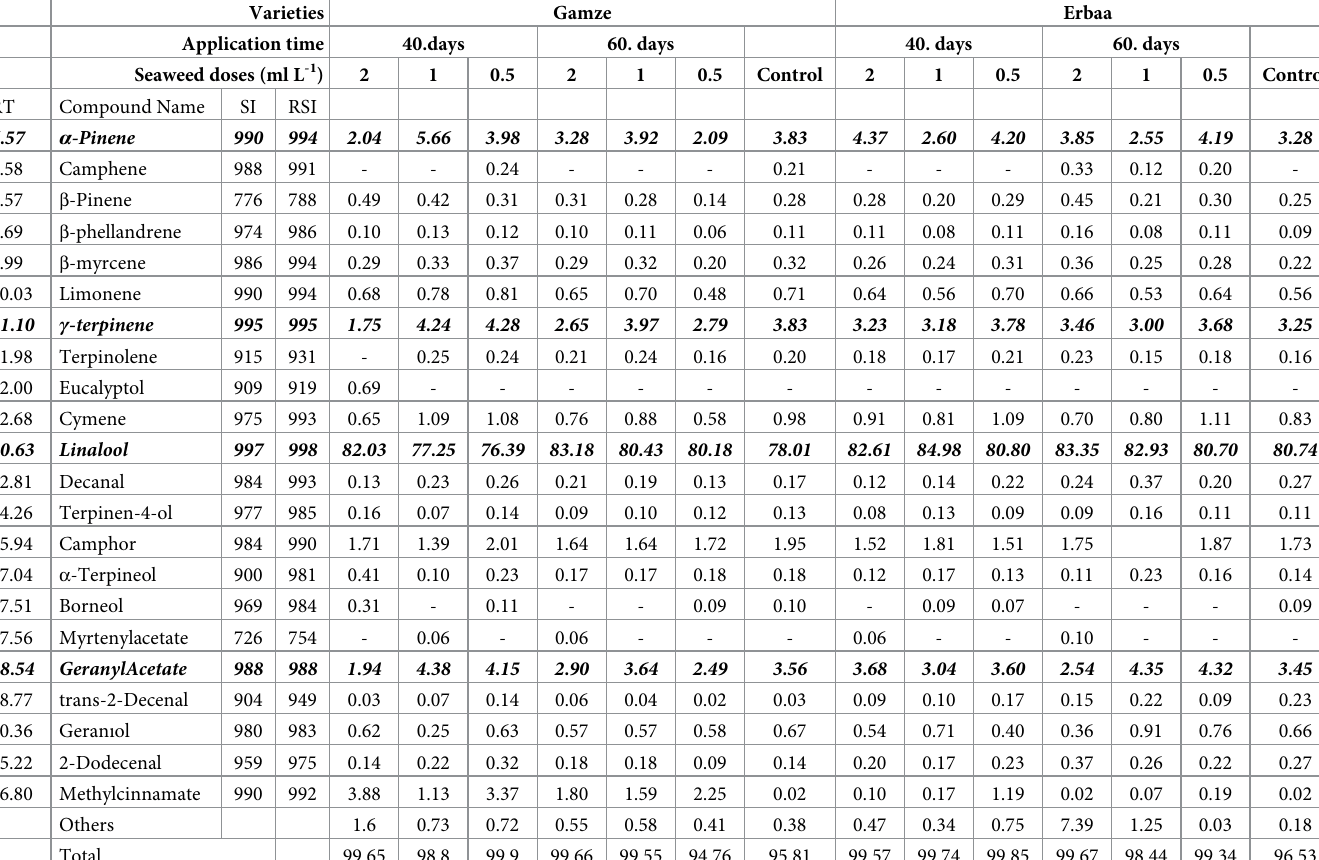
Table 6. Essential oil ratios of the two coriander varieties applied with different seaweed doses at different times (day 40 and day 60) at location A. Varieties Gamze Erbaa Application time 40.days 60.